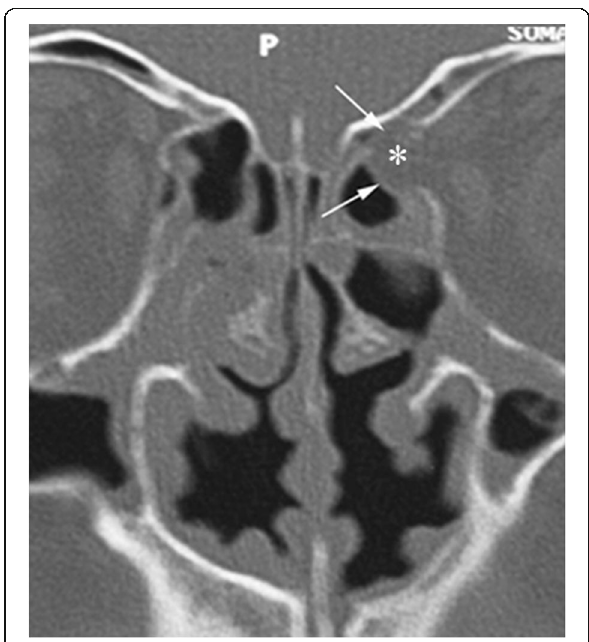
Fig. 4 Orbital wall dehiscence. The thin lamina papyracea is focally interrupted on the left side (arrows), where a small amount of extraconal fat tissue (asterisk) protrudes into the ethmoid labyrinth